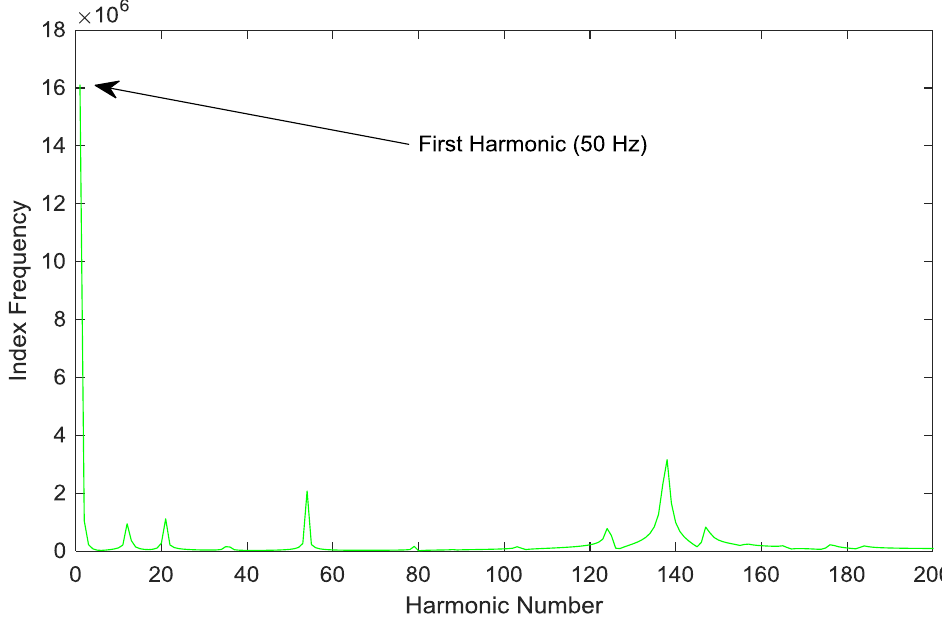
Figure 13. Frequency component waveform of the possible fault in section (3-9).